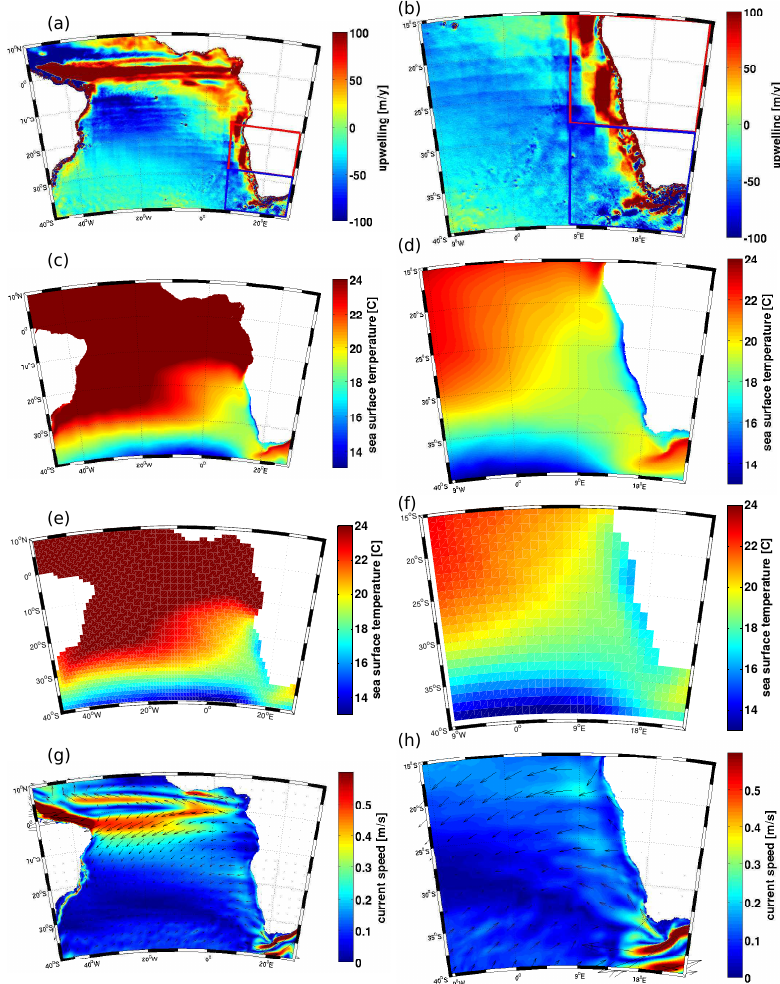
Figure 2. Long-term mean of the annual mean upwelling velocity at 52m depth of the STORM simulation (1950–2010) for two regions in the South Atlantic (a, b) , the boxes indicate the regions used for the upwelling index of North Benguela (red) and South Benguela (blue). The long-term annual mean simulated sea surface temperature of the STORM simulation (1950–2010) (c, d) , the long-term mean annual sea surface temperature of HadISST1 (1870–2012) (e, f) and the simulated long-term annual mean surface of the STORM simulation (1950–2010) (6m depth) currents (g, h)